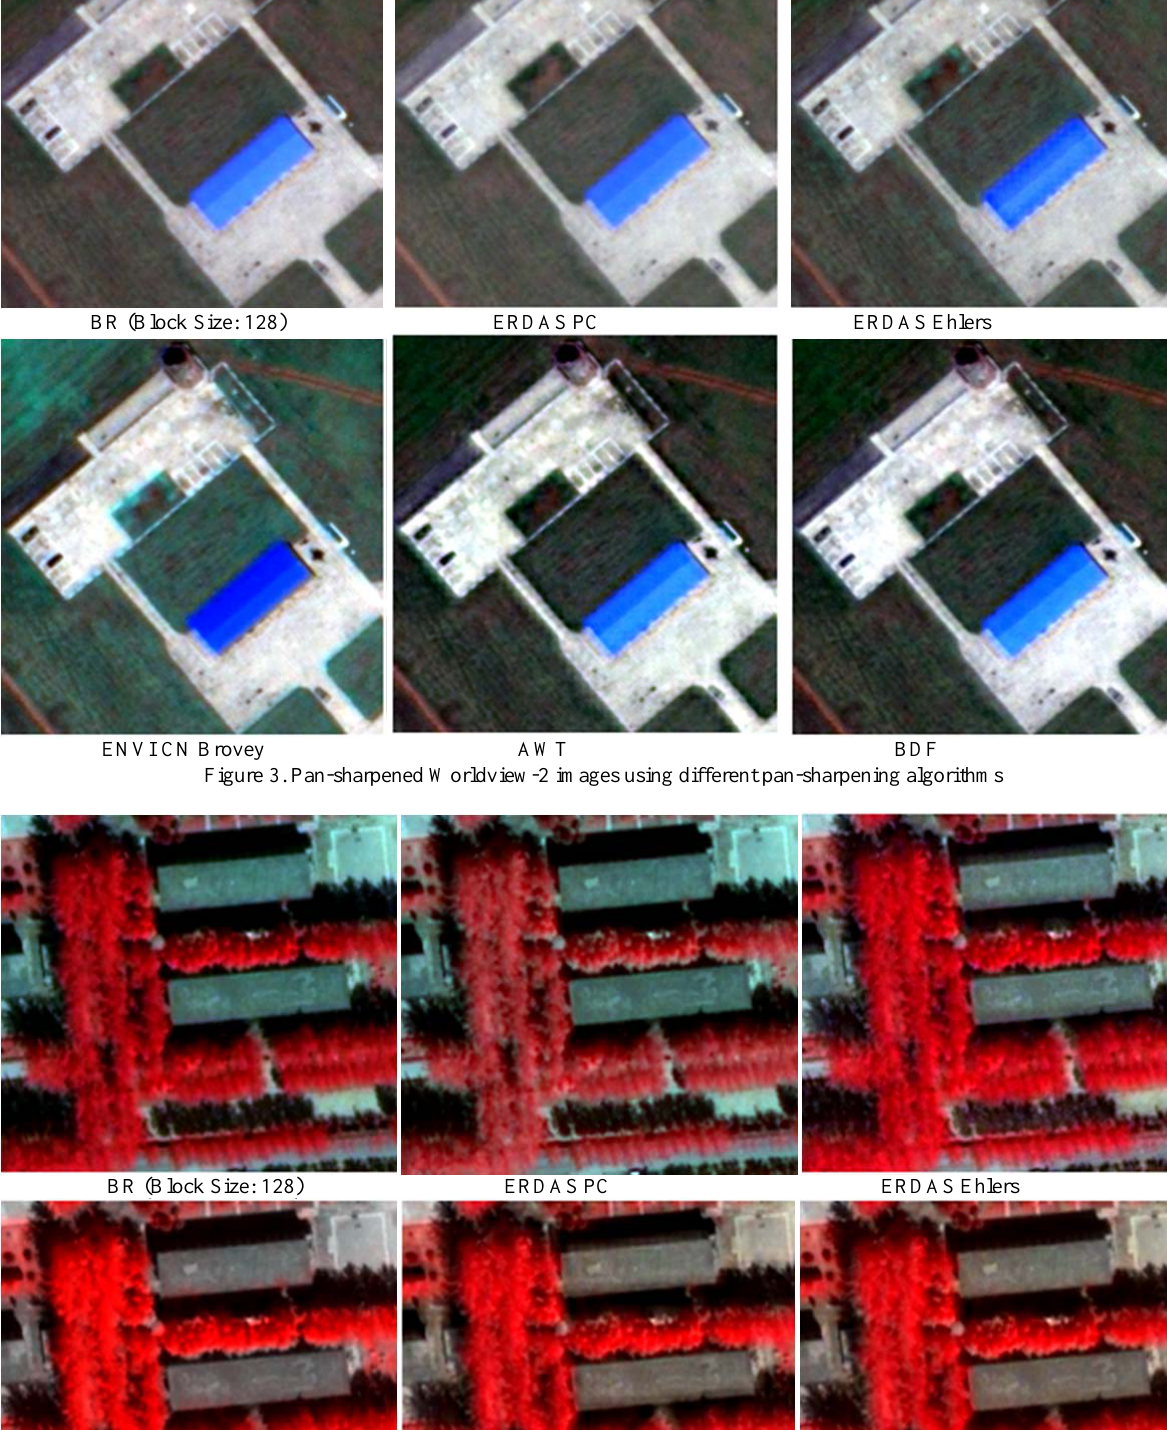
BR (Block Size: 128)